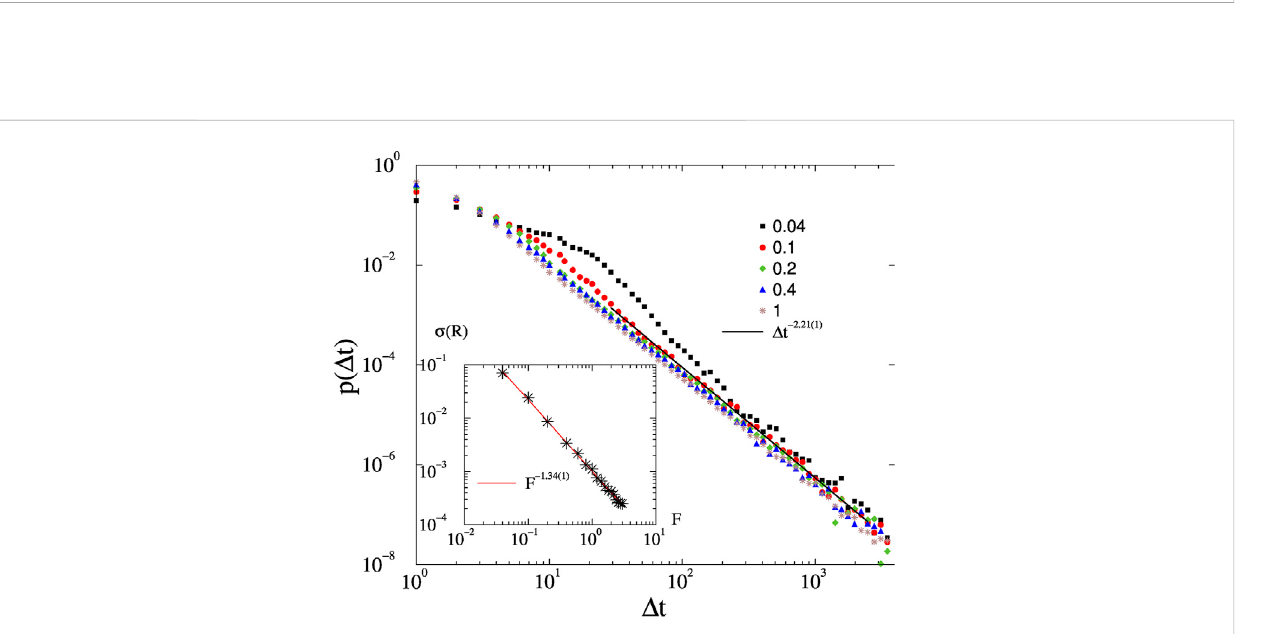
Avalanchedurationdistributionsonthefruit- fl yconnectomefordifferentforces,shownbythelegendsandat K =2, ϵ =0.01.DashedlinesarePL fi ts for Δ t > 100. The inset shows σ ( R ) by increasing F on log. log. scale. The line corresponds to a PL fi